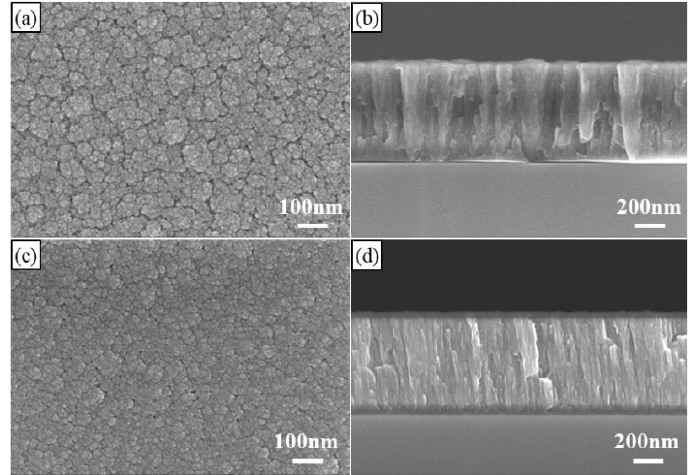
Figure 2. ( a , c ) Surface and ( b , d ) Cross-sectional images of the amorphous carbon films deposited with different discharging gases ( a , b ) Ne, ( c , d ) Ar.